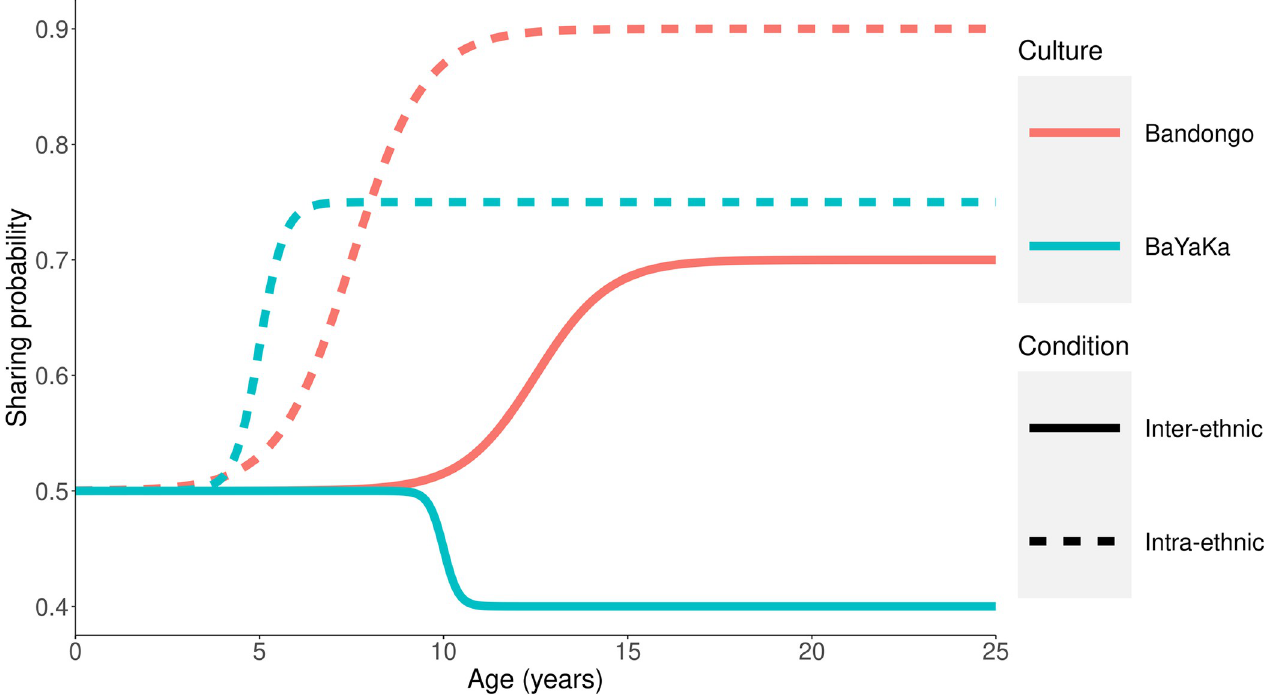
Fig 2. Example developmental trajectories which can be expressed within the proposed modelling framework. Colours correspond to societies and line types correspond to intra- and inter-ethnic sharing rates within each society. At age zero, all participants are expected to behave identically. By adulthood, each society is expected to have distinct intra- and inter-ethnic sharing norms. The change between these endpoints can happen at different ages and different rates across both society and condition. Here, BaYaKa children acquire norms suddenly (blue curves) while Bandongo norms shift more gradually (red curves).